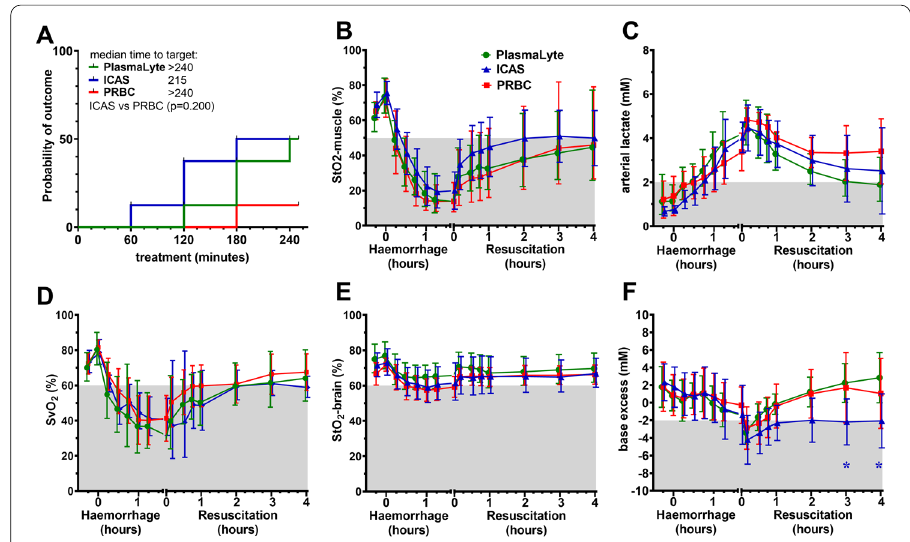
Fig. 3 Primary and secondary tissue oxygen delivery outcomes. A Time to treat analysis of composite tissue oxygen delivery target (muscle StO 2 50% and arterial lactate 2 mM). B Regional tissue oxygen ≥ ≤ saturation‑muscle. C Arterial lactate. D Venous oxygen saturation. E Regional tissue oxygen saturation‑brain. F Arterial base excess. Shaded areas represent levels outside the normal range or treatment target. Data shown as mean or geometric mean according to normality test, with 95% confidence intervals. Mixed model ANOVA with Tukey correction for multiple comparisons; * p < 0.05